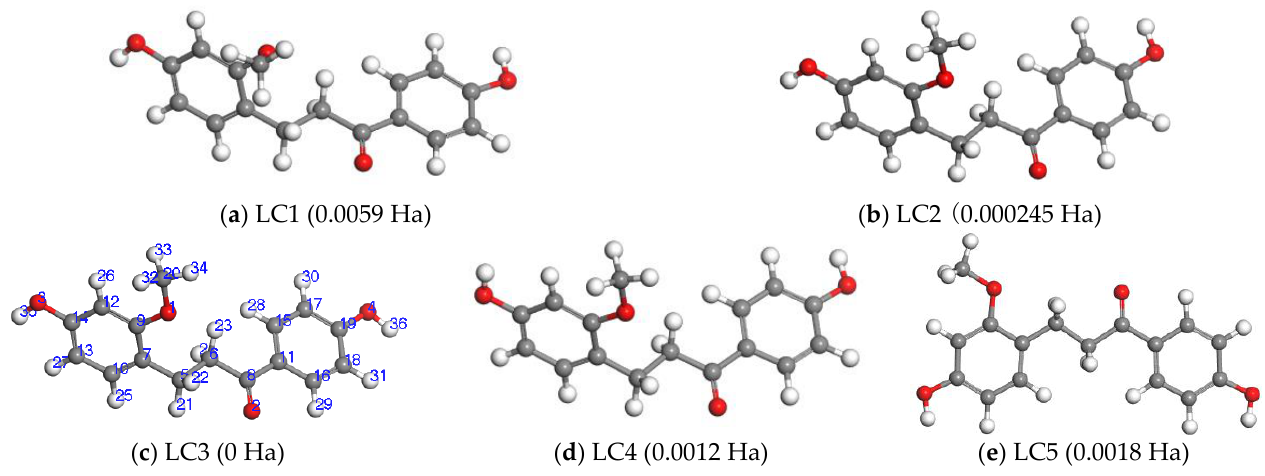
Figure 3. The optimized structures of LC in gas phase. (The numbering scheme for LC are shown in Figure 3c). Table 1. Structure parameters of different LC conformation (bond length/Å, bond angle, and dihedral angle/°).